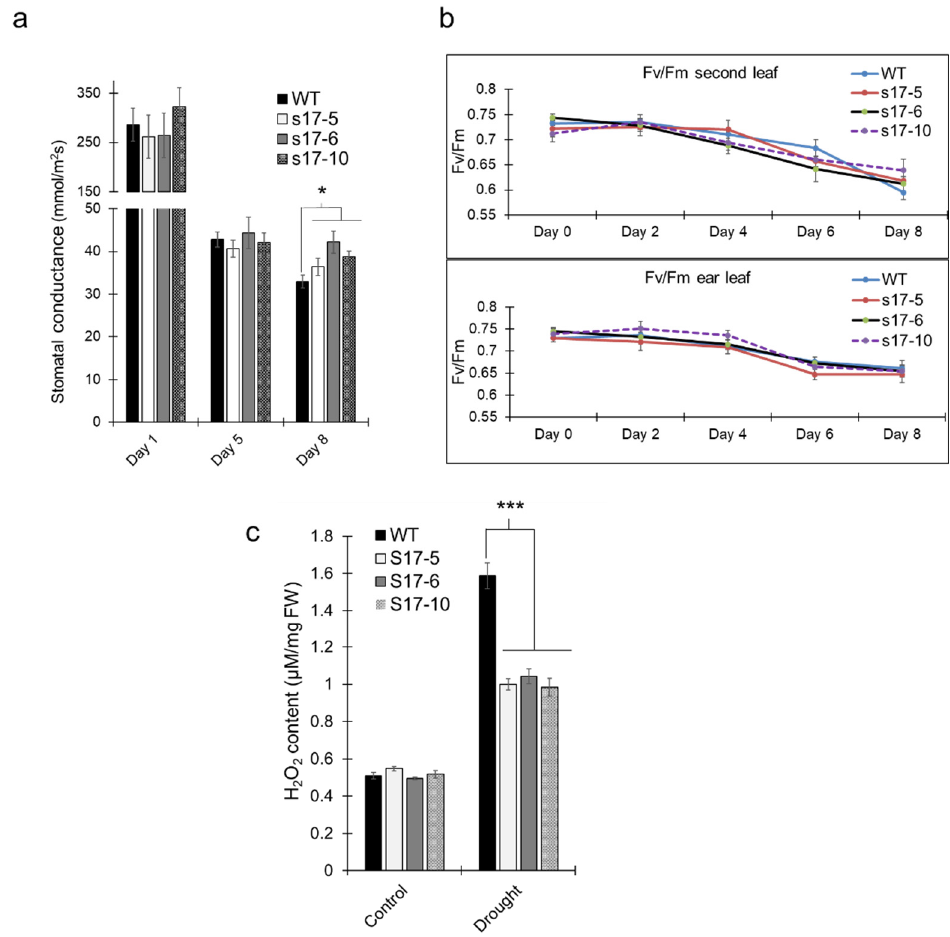
Figure 4. Effect of ectopic expression of AtGRXS17 in stomatal conductance and H 2 O 2 content. ( a ) Stomatal conductance of WT and AtGRXS17 -expressing maize plants at VT stage as the drought progresses; ( b ) Chlorophyll fluorescence measurement of the ear leaf and second leaf from top in WT and AtGRXS17 -expressing maize plants at VT stage as the drought progresses; ( c ) H 2 O 2 content of the WT and AtGRXS17 -expressing maize plants under control (well-watered) and drought stress after 8 days. Data shown are Mean ± SE ( n = 6) and were analyzed using one-way ANOVA. Asterisks indicate significance level (* p < 0.05, *** p < 0.001).